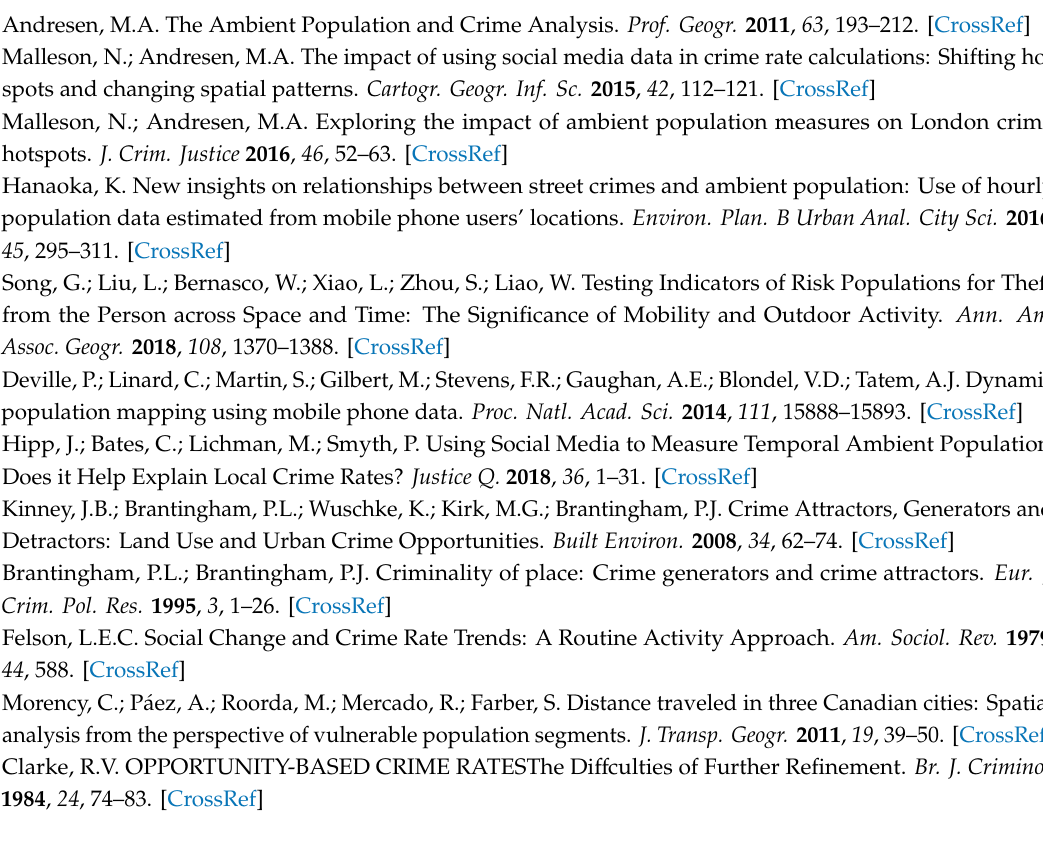
Figure S1. The results of non-linear correlation test using “nlcor”